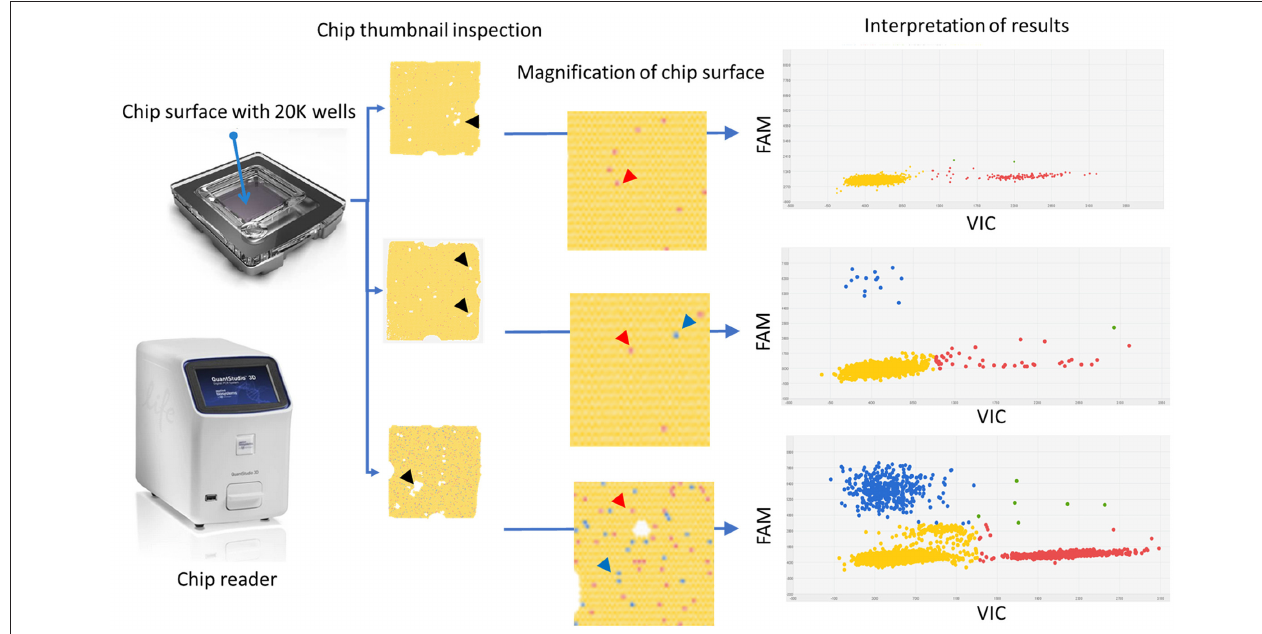
FIGURE 2 | Graphical description of the digital PCR assay workflow including selected examples of results. On the left, the chip and chip reader instrument. The thumbnail appearance of the chip surfaces and their magnifications are reported. They are used to assess whether there is a homogeneous coverage of the chip surface and to rule out the presence of dust or debris or “bubble” or other event detrimental for the quality of the readings. White spots represent areas in which the reaction mix did not fill the wells (black harrow head). At high magnification wells could be identified. Each dot represents a well containing either “no fluorescence” as yellow dots (prevalent background) or “VIC fluorescence” as red dots (red arrow heads) or “FAM fluorescence” as blue dots (blue arrow heads). On the right, the plot two-axis graphical representation of the results. The X-axis reports the VIC fluorescence (wild-type target) while the y-axis reports the FAM fluorescence (mutated target); each dot represents a well containing fluorescence; the green dots and the yellow dots are either VIC and FAM positive wells or negative wells, respectively. Red dots and blue dots represent wells containing only VIC (wild-type target) or FAM (mutated target) fluorescence, respectively. On the right, from top to bottom: negative sample (only red dots and yellow dots), positive diluted sample (few positive wells with high percentage of mutated “target FAM”), and positive concentrated sample (many positive wells with high percentage of mutated “target FAM”). It is worth noting that only at high target concentrations do the clusters tend to